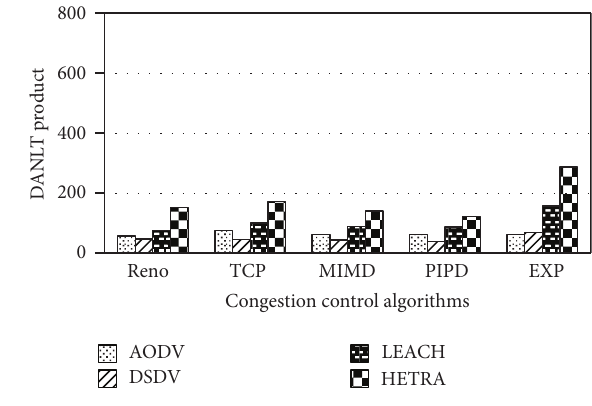
Figure 10: DANLT product for Pattern 3.